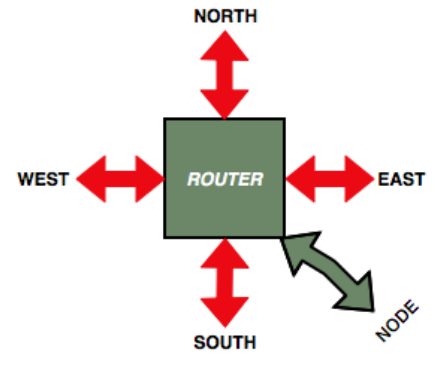
Figure 4. A router with five ports